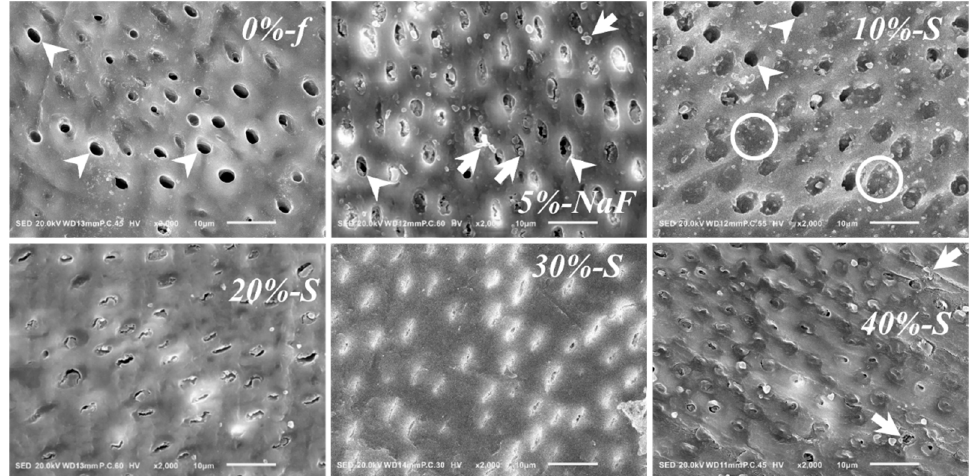
Figure 8. SEM images of the scraped part of root dentin surfaces after 7 days of biofilm ‐ induced acid attack; original magnification: 2k. In 0 ‐ f% , completely open DTs (arrowheads) are seen more, with only a few remained plugged by the filler ‐ less material. Apparently, 5% ‐ NaF had decomposed DV particles (arrows) at the opening of DTs and some complete DT openings are seen. Few completely open DTs are seen in 10% ‐ S (arrowheads) and some are plugged with DV containing a proportionally smaller amount of fillers (circles). No completely open DTs are seen in 20% ‐ S ; there are more partially open. In 30% ‐ S , only crack ‐ like DT openings are seen. Most DTs remain completely occluded in 40% ‐ S ; decomposed DV particles are also seen at the DT opening (arrows).